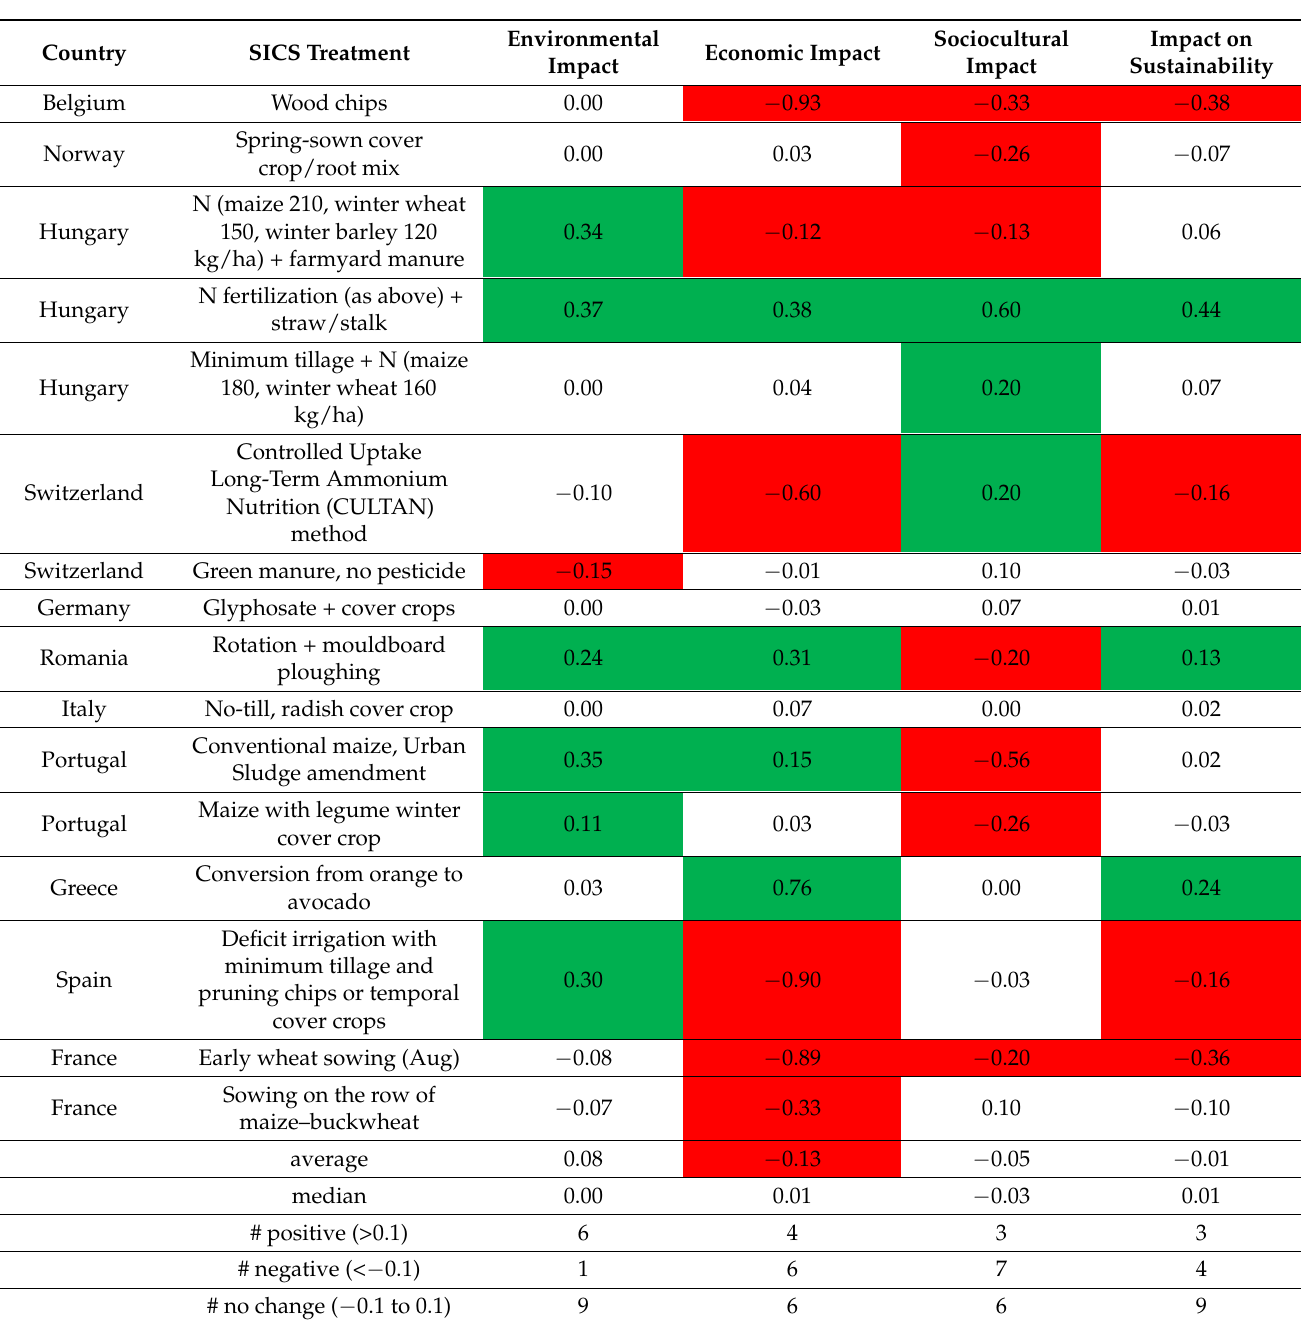
Table 2. Results of SICS analysis based on the developed assessment methodology [80]. Values were scored on a range from − 1 to 1 for those experiments where data on all three dimensions were available (see [79]). Details on experiments can be found in [79]. Impact on sustainability was the average of environmental impact, economic impact, and sociocultural impact. Negative impacts are indicated by red and positive ones by green. More details are provided in Table